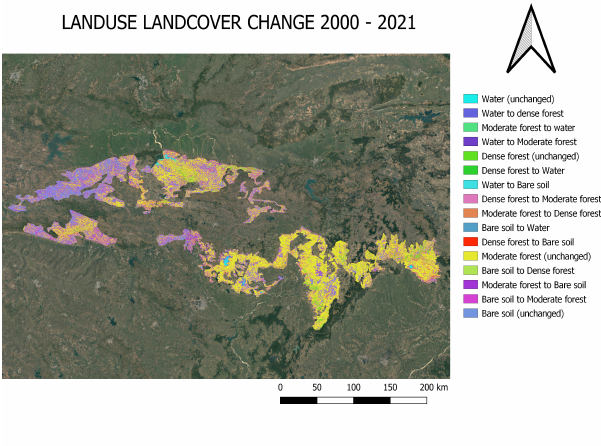
Figure 10: LULC Change 2015 - 2021